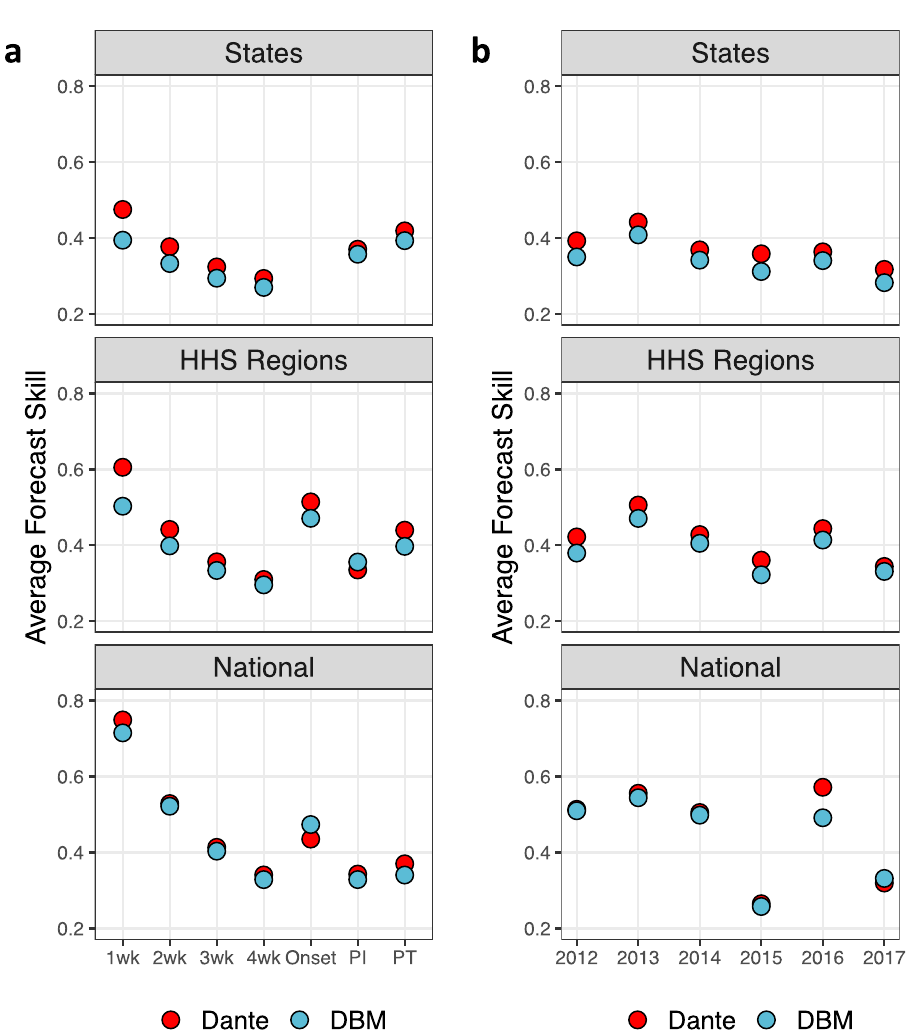
Fig. 5 Dante ’ s and DBM ’ s forecast skill by target and season. a Average forecast skill by scales and targets. PI and PT stand for peak intensity and peak timing, respectively. Dante outperformed DBM for all scales and targets, except for onset nationally and for PI regionally. b Average forecast skill by scales and fl u seasons. Dante outperformed DBM for all scales and targets, except for 2017